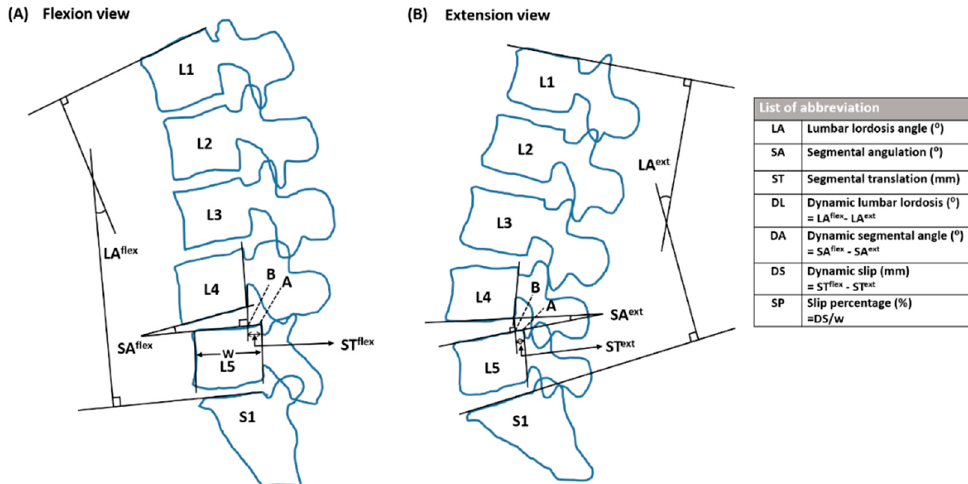
Figure 1. The measurement diagram for detecting motion segments of lumbar spine in flexion ( A ) and extension ( B ) views. Lumbar lordosis angle (LA) was defined as the angle between the tangential lines of the superior endplates of L1 and S1. To measure the segmental angulation (SA), tangent lines were drawn along the lower endplate of superior vertebra (such as L4) and upper endplate of inferior vertebra (such as L5); those two lines form SA. To measure segmental translation (ST), a perpendicular line from the posterior margin of lower endplate of superior vertebra of L4 to the line of upper endplate of inferior vertebra of L5 was added, and the length between A and B